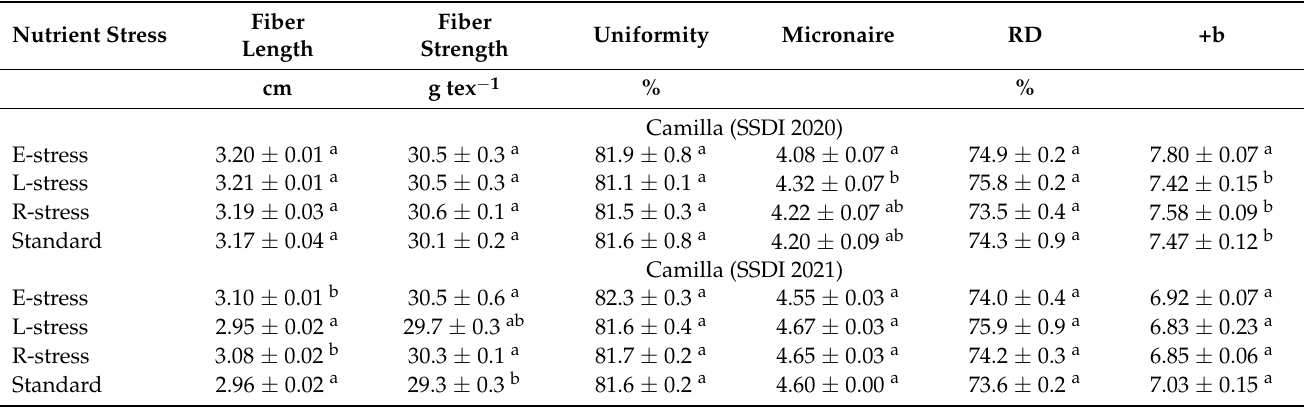
Figure 4. Nutrient stress effects on the total aboveground biomass in Camilla ( a – c ) and Midville ( d – f ), GA under different production conditions. Within production conditions and growth stage, means of nutrient stress treatments not sharing any letter are significantly different using the least squares means and adjusted Tukey multiple comparison procedure ( p < 0.05). Error bars indicate the standard error of the mean (n = 4). SSDI: Sub-surface drip irrigation; WoB: Week of bloom. Table 3. Nutrient stress effects on cotton fiber quality in Camilla and Midville under different production